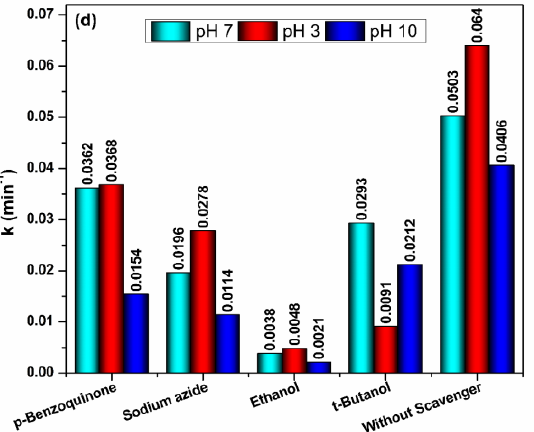
Figure 7. Radical scavenging experiments at ( a ) pH 3, ( b ) pH 7 and ( c ) pH 10, along with ( d ) the rate of reactions.